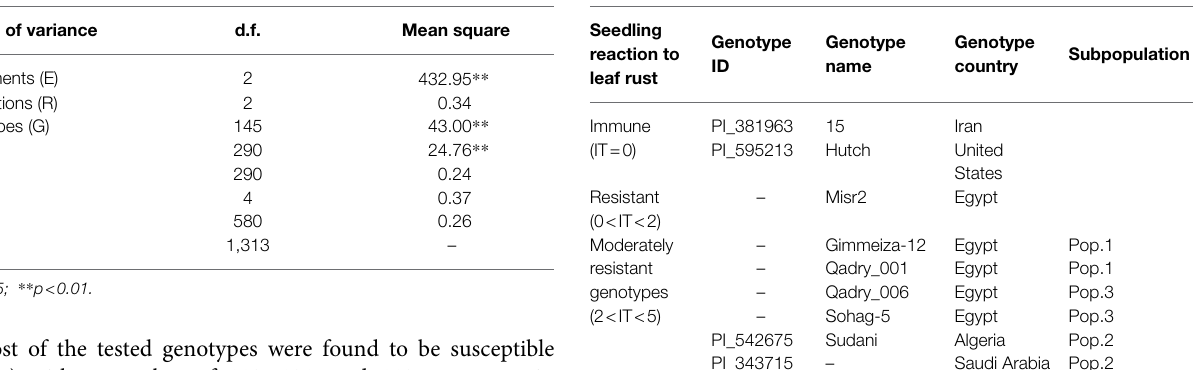
TABLE 2 | List of common immune, resistant and moderately resistant genotypes in Exp.S.I., Exp.S.II., and Exp.A., their country of origin, and plant